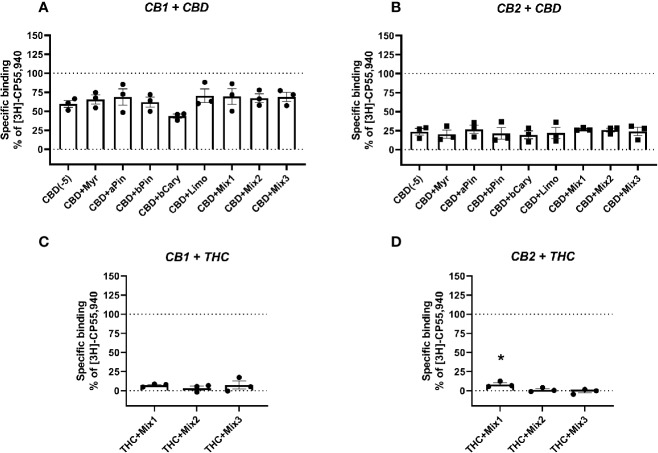
Specific binding of [3H]-CP55,940, with displacement by CBD (A, B) or THC (C, D) in the presence and absence of terpenes (all at 10 µM) in membranes containing hCB1 (A, C) or hCB2 (B, D). Binding data are normalized to total [3H]-CP55,940 binding in the absence of displacer (100%), and in the presence of 10 µM THC (0%). Data are means ± SEM of three independent determinations. *p < 0.05.